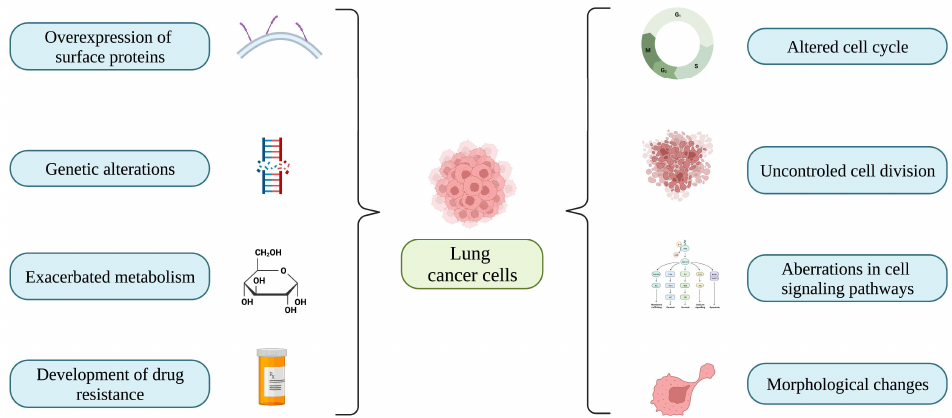
Figure 1. Features of lung cancer cells: overexpression of surface proteins, genetic alterations, exac- erbated metabolism, drug resistance, altered cell cycle, uncontrolled cell division, aberrations in cell signaling pathways, and morphological changes.